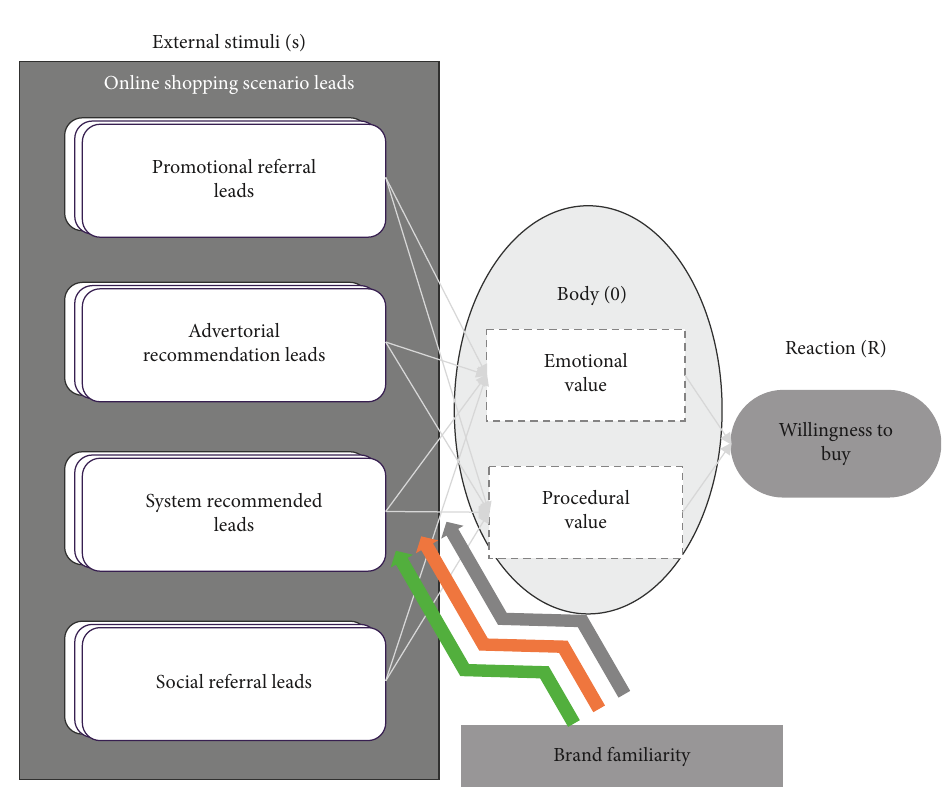
Figure 6: Research model on the influence of online shopping situational cues on consumers’ purchase